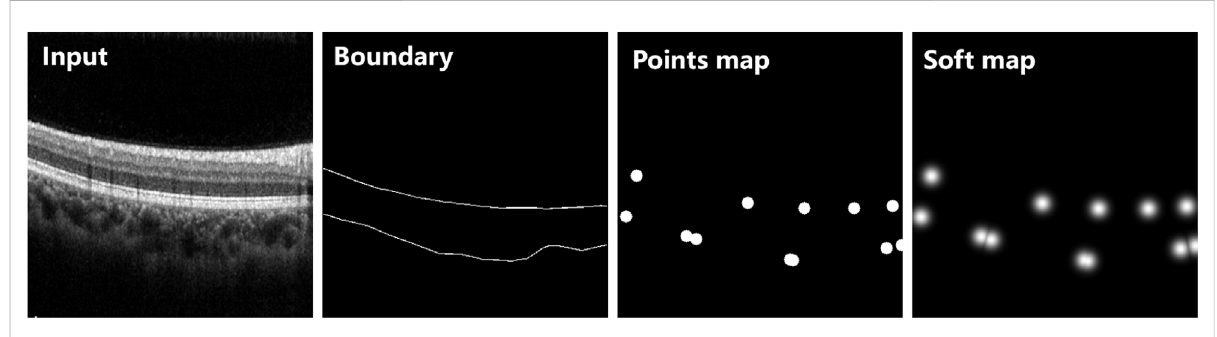
FIGURE 3 Two different types of point maps extracted from the same OCT B-scan. The original points map was generated using binary disk as (Lee et al., 2020), while the soft map was generated based on a two-dimensional Gauss function. All points were extracted from the same boundary of ground truth.